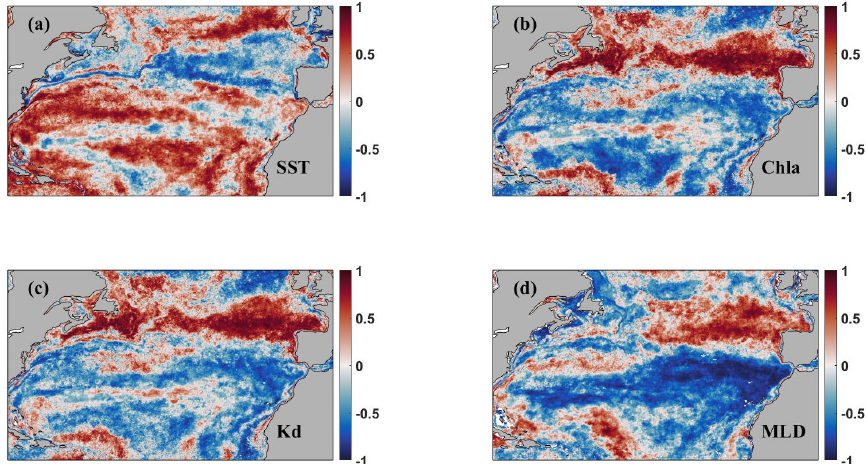
Figure 11. Maps of correlation coefficients between annual mean SST ( a ), Chla ( b ), Kd ( c ), MLD ( d ), and surface pCO 2 respectively.